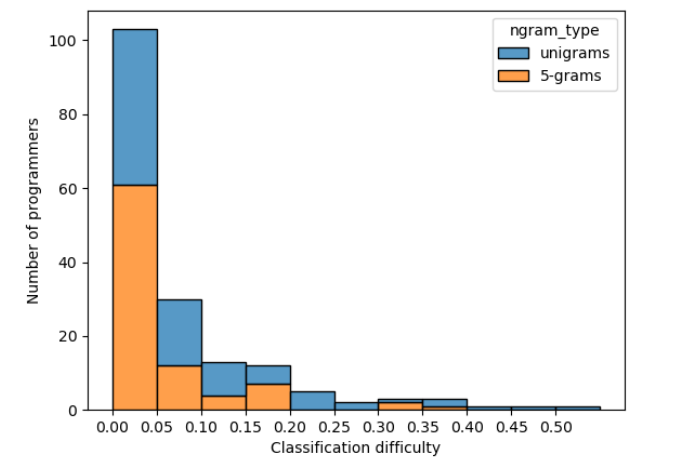
Figure 5. Histogram of classification difficulty for 87 developers and unigram features (blue) and 5-gram features (yellow) and doc2vec vector size of